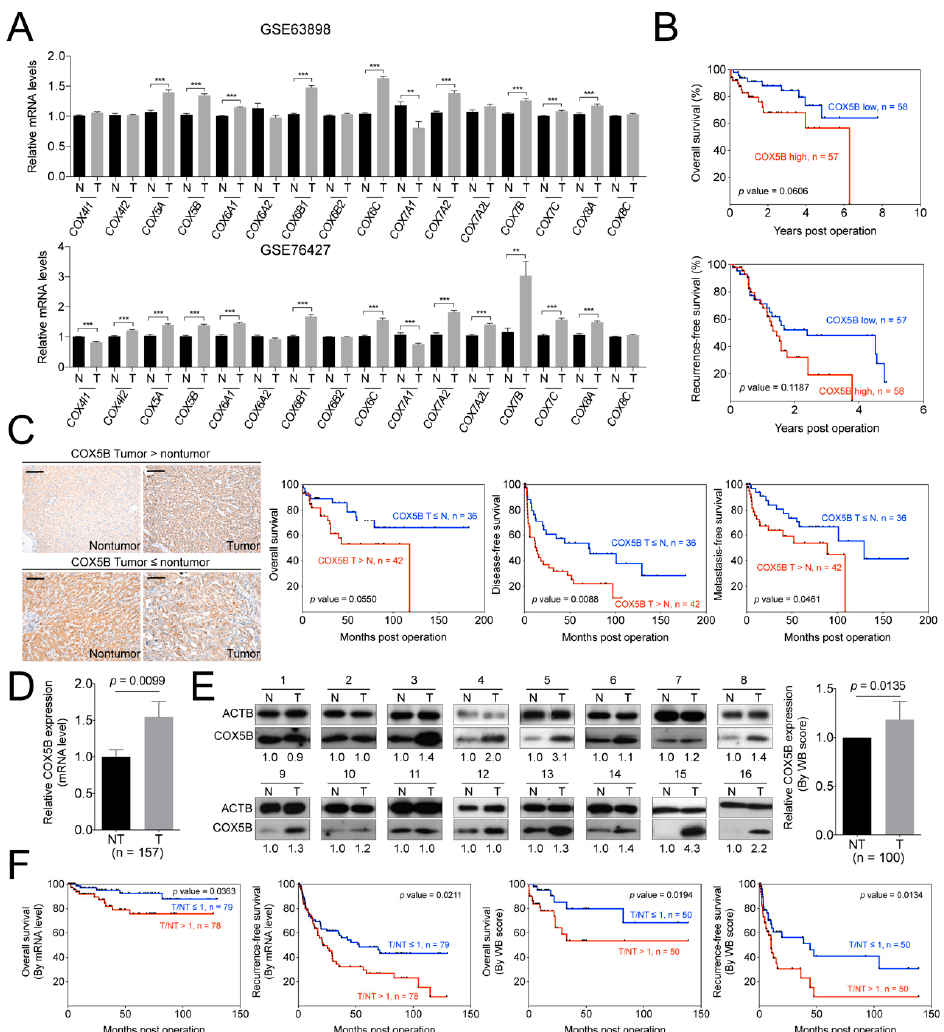
Figure 1. COX5B acts as a potent growth-promoting gene in hepatoma. ( A ) The GSE63898 and GSE76427 datasets were employed to analyze the expression levels of various cytochrome c oxidase genes in hepatoma, tumorous versus nontumorous parts. T, tumorous part. N, nontumorous part. ***, p < 0.001; **, p < 0.01. ( B ) The prognosis of hepatoma patients included in GSE76427 dataset was analyzed by Kaplan-Meyer method with the mean of mRNA levels in the tumorous parts as cutoff. ( C ) The representative IHC sections in patient with higher COX5B intensity in the tumorous tissues (tumor > nontumor, left upper panel) or higher in nontumorous tissues (tumor ≦ nontumor, left lower panel) in hepatoma. The black scale bar represented 100 μ m. The Kaplan-Meyer analysis of the prognosis of hepatoma patients stratified according to the intensity of the COX5B IHC staining (right three panels, overall survival, disease-free survival and metastasis-free survival). The ( D ) mRNA and ( E ) protein levels of COX5B in tumorous and nontumorous parts of hepatoma retrieved from our tissue bank. The images in this panel were all acquired by exposing the luminescent signals to x-ray films. The p value was derived by paired two-tail student t -test. T, tumorous part. N, nontumorous part. ( F ) The Kaplan-Meyer analysis for prognosis of hepatoma patients divided by the mean of the tumorous/nontumorous ratios of COX5B mRNA (left two) and protein (right two) levels.